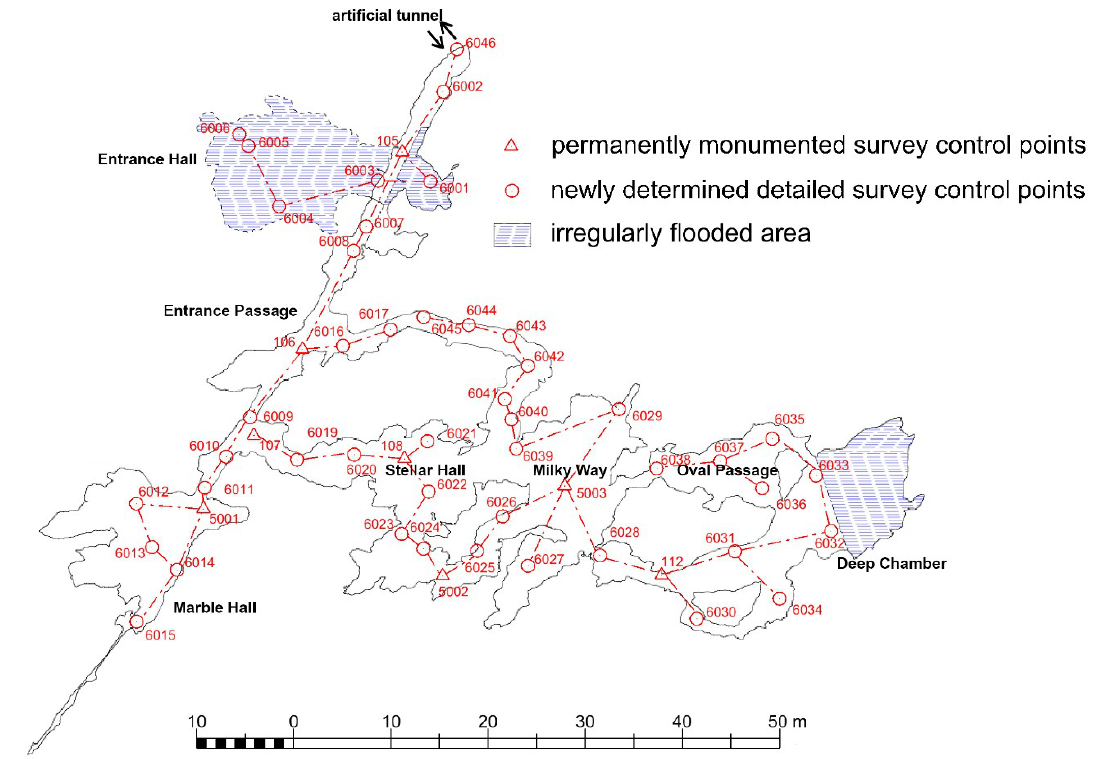
Figure 5. New detailed map of the Ochtiná Aragonite Cave with the overall situation of scanning survey